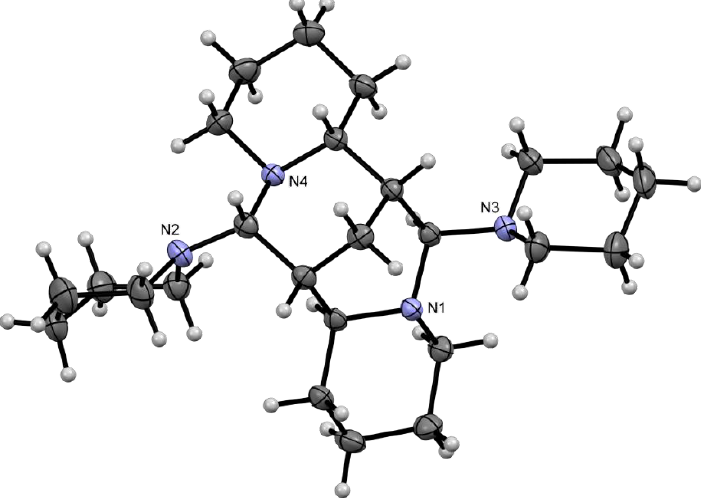
Figure 10. ORTEP drawing of polycyclic piperidine compound 10 . Displacement ellipsoids are drawn at the 50% probability level. Hydrogen atoms are shown as spheres of arbitrary radii.